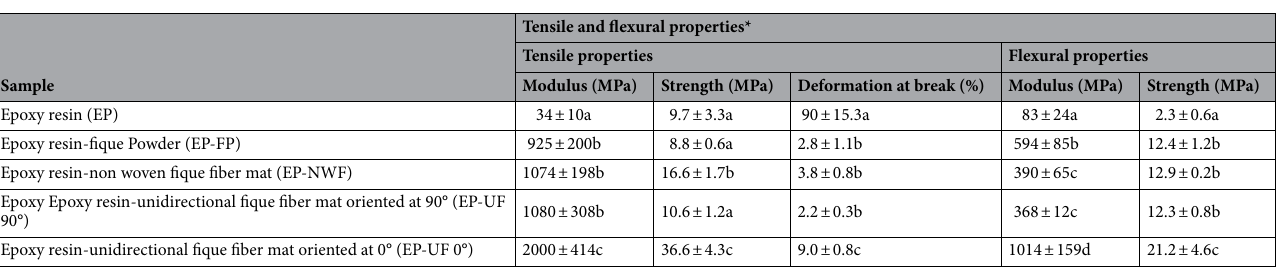
Table 1. Tensile and flexural properties of EP and EP-fique biocomposites. a–c Different letters in the same column indicate significant differences ( p < 0.05). *Average of five replications ± standard deviation.